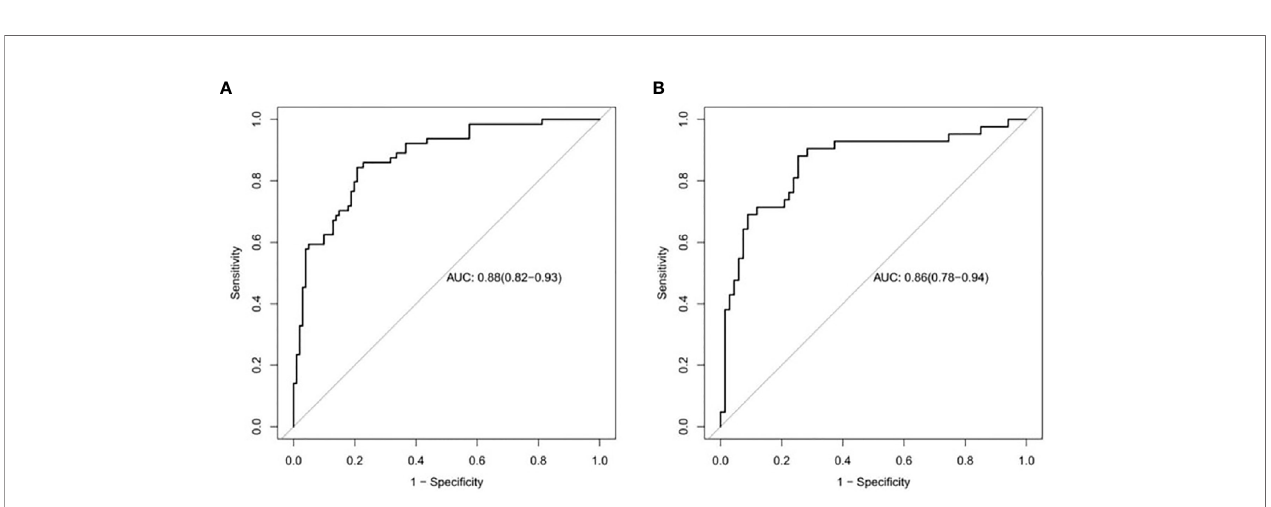
FIGURE 5 | ROC curves to distinguish low Ki-67 lung cancer from high Ki-67 lung cancer based on the CT imaging model prediction model. The AUC in the training set was 0.88. (A) , and that in the validation set was 0.86 (B) .